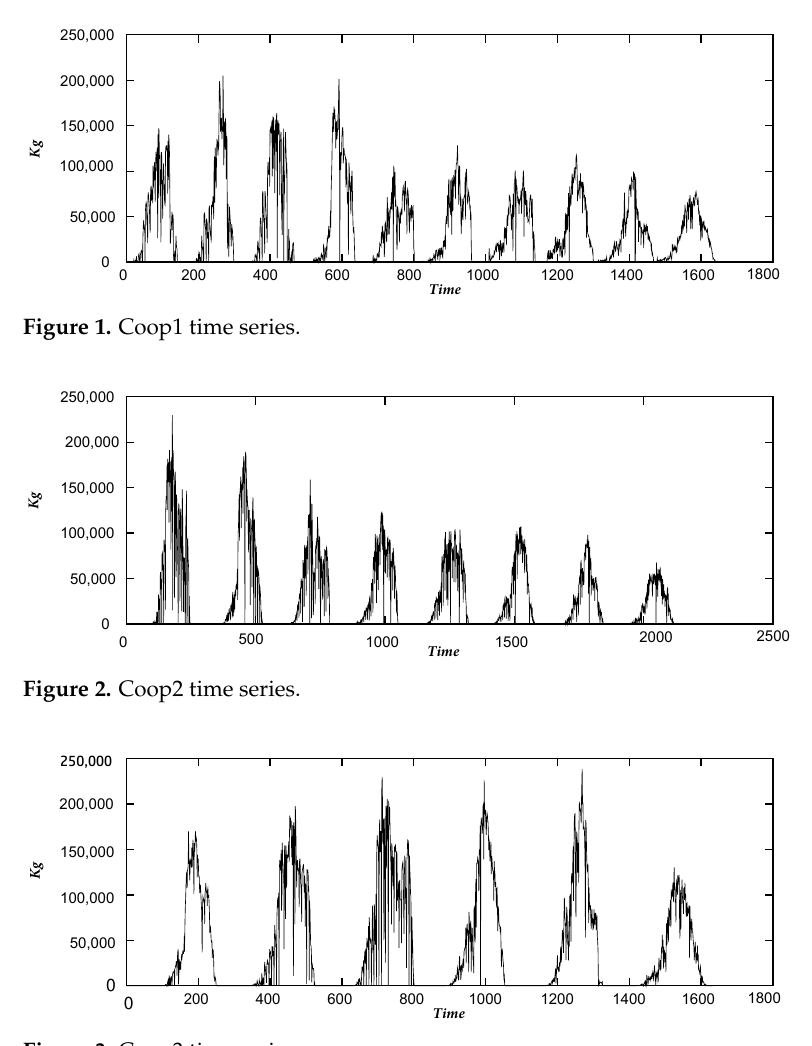
Figure 3. Coop3 time